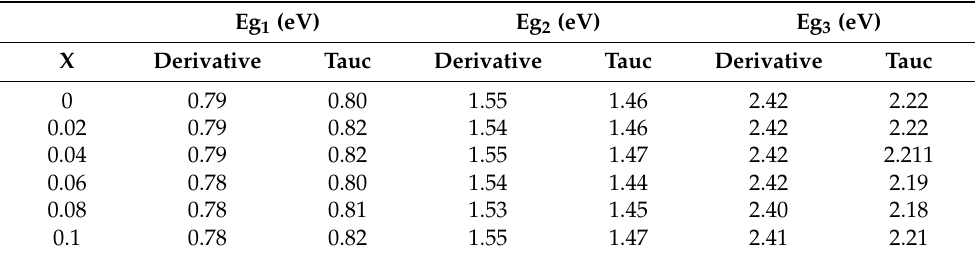
Table 2. The energy band gaps (E g1 , E g2 and E g3 ) obtained from Tauc and derivative relations, hopping lengths and sub-sites radii for Cr x Co 3 − x O 4 thin film samples.